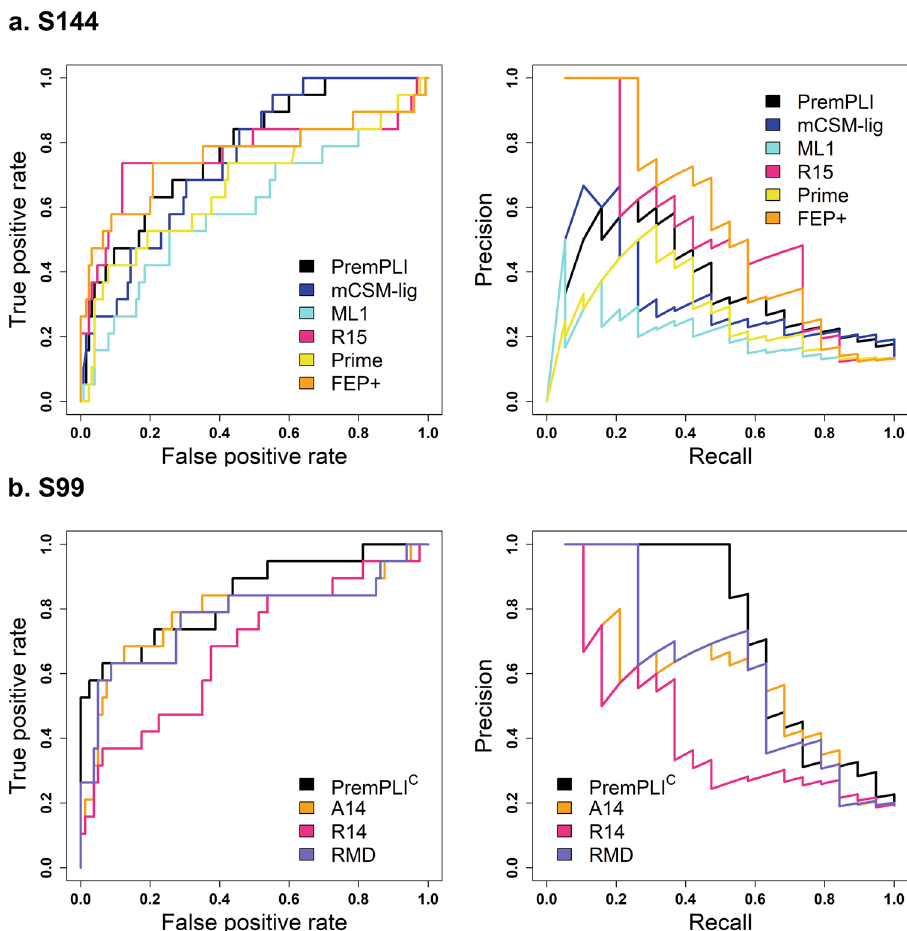
Fig. 4 Receiver operating characteristics (ROC) and precision recall (PR) curves for different methods to distinguish resistance from other mutations. The number of resistance mutations is 19 for both S144 ( a ) and S99 ( b ) datasets.